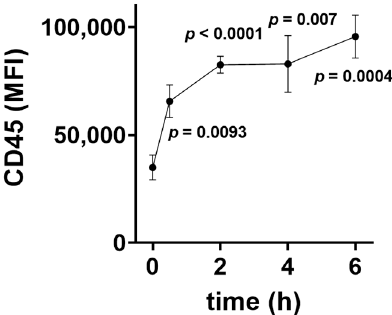
Figure 2. Time course of the lipopolysaccharide (LPS)-induced CD45 surface expression on human granulocytes in 6 volunteers. Whole blood samples were incubated with 100 ng/mL LPS for various time intervals; CD45 surface expression was determined with cell cytometry and labeling of cells with fluorescent CD45 antibodies. Values are given as mean and SEM. p : Student’s t -test significance level of the difference of mean fluorescence intensity between t = 0 and the respective time point.